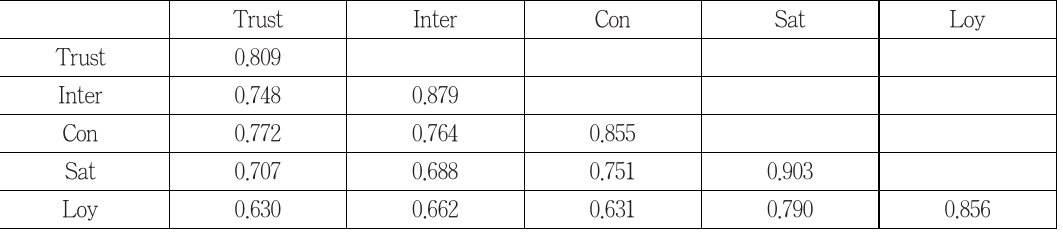
<Table 4> Discriminant validity: Fornell-Larker